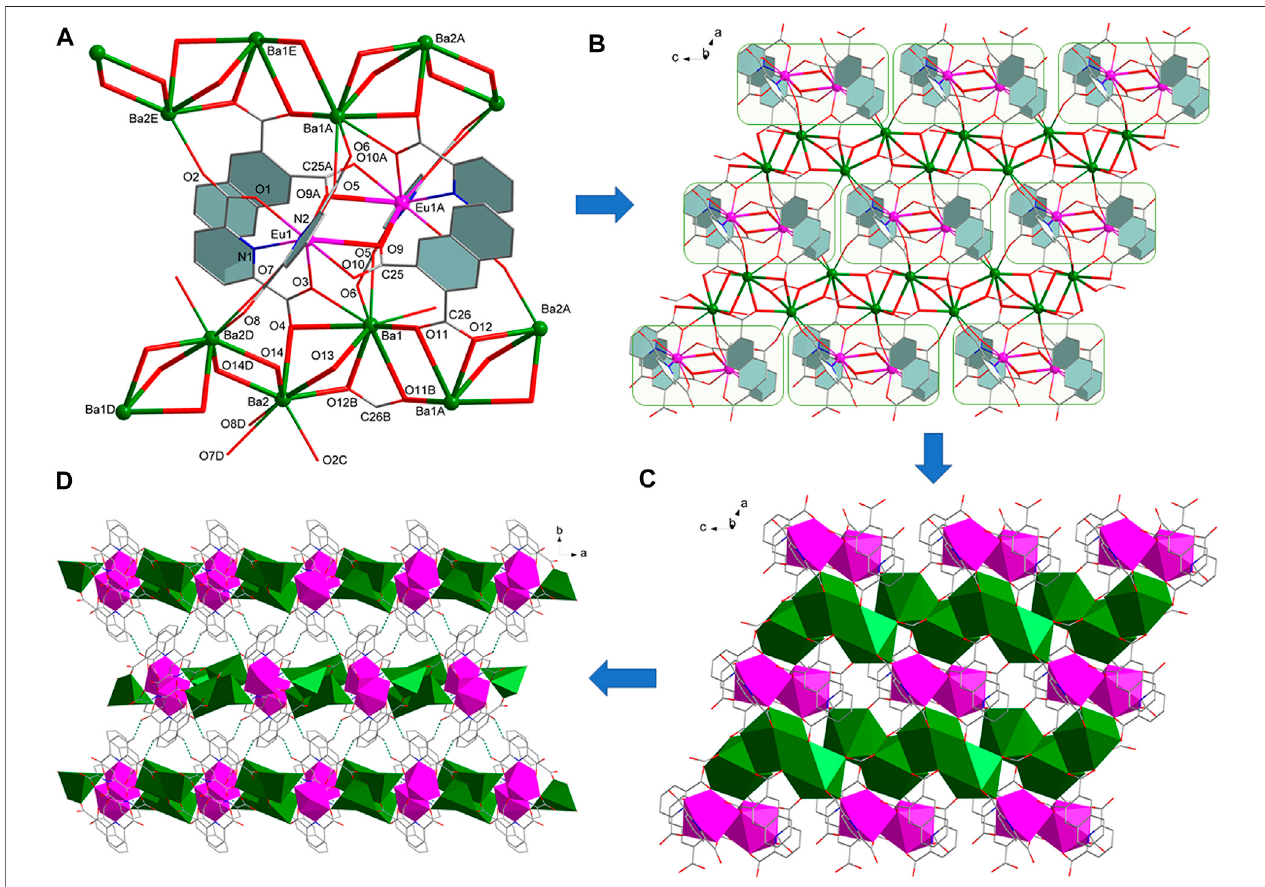
FIGURE 2 | (A) The coordination environment of metal ions in 5 . (B) 2D layer structure of 5 . (C) 2D layer diamond structure of 5. (D) Hydrogen bond packing diagrams of 5.